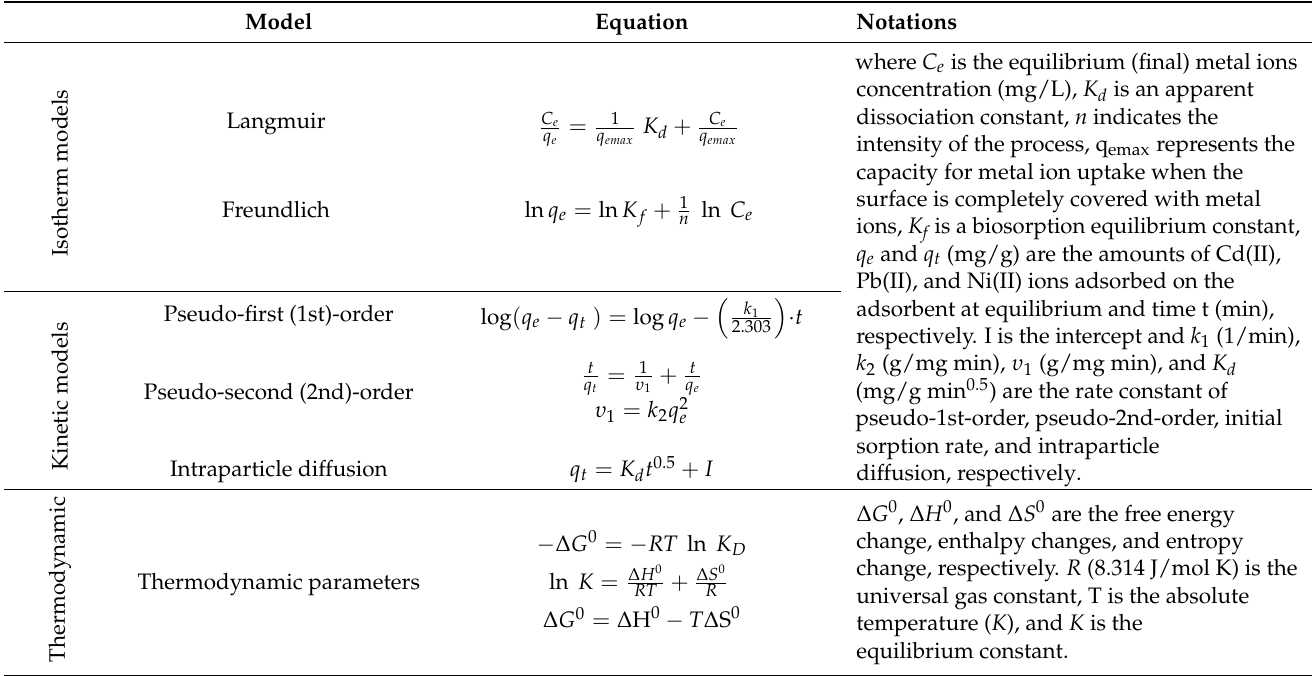
Table 1. Mathematical equations of both isotherm and kinetic models, and thermodynamics parame- ters utilized for the empirical data analysis. Model Equation Notations